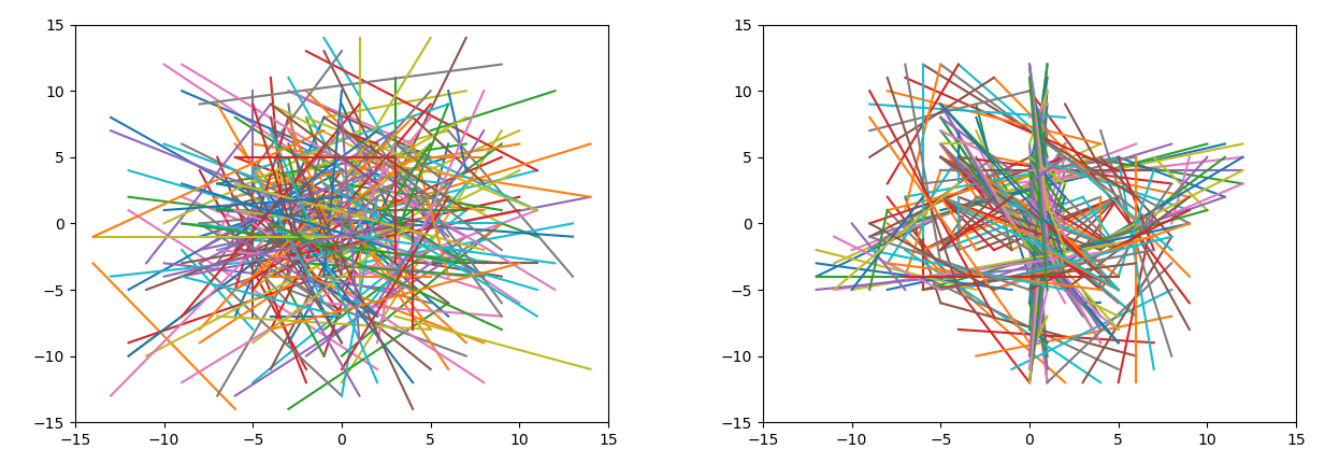
Figure 10. Comparison of the test location pattern used in the original BRIEF algorithm ( left ) with that obtained by our RS-BRIEF implementation ( right ).